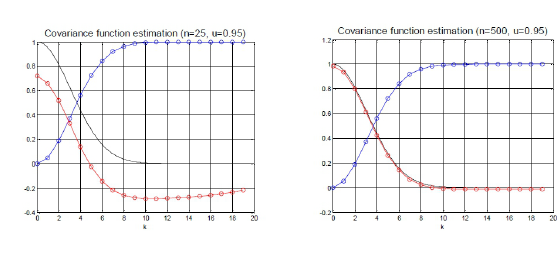
Figure 3. Simulation study of the traditional covariance function es- timate and the semivariogram. For small n-values the tra- ditional approach (left) produces biased covariance esti- mates and an underestimated Ω - value, but the semivari- ogram (right) has – if “reversed” – a better correspondence with the true covariance function. 100.000 sample runs. Red: Mean value of the traditional covariance function es- timates. Blue: Mean value of the estimated semivariograms. Black: True covariance function, r ( τ ) = 0 . 95 τ 2